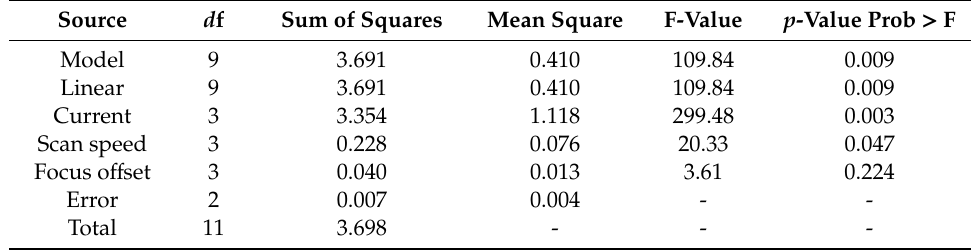
Table 4. ANOVA for the effect of EBM process parameters on support removability.